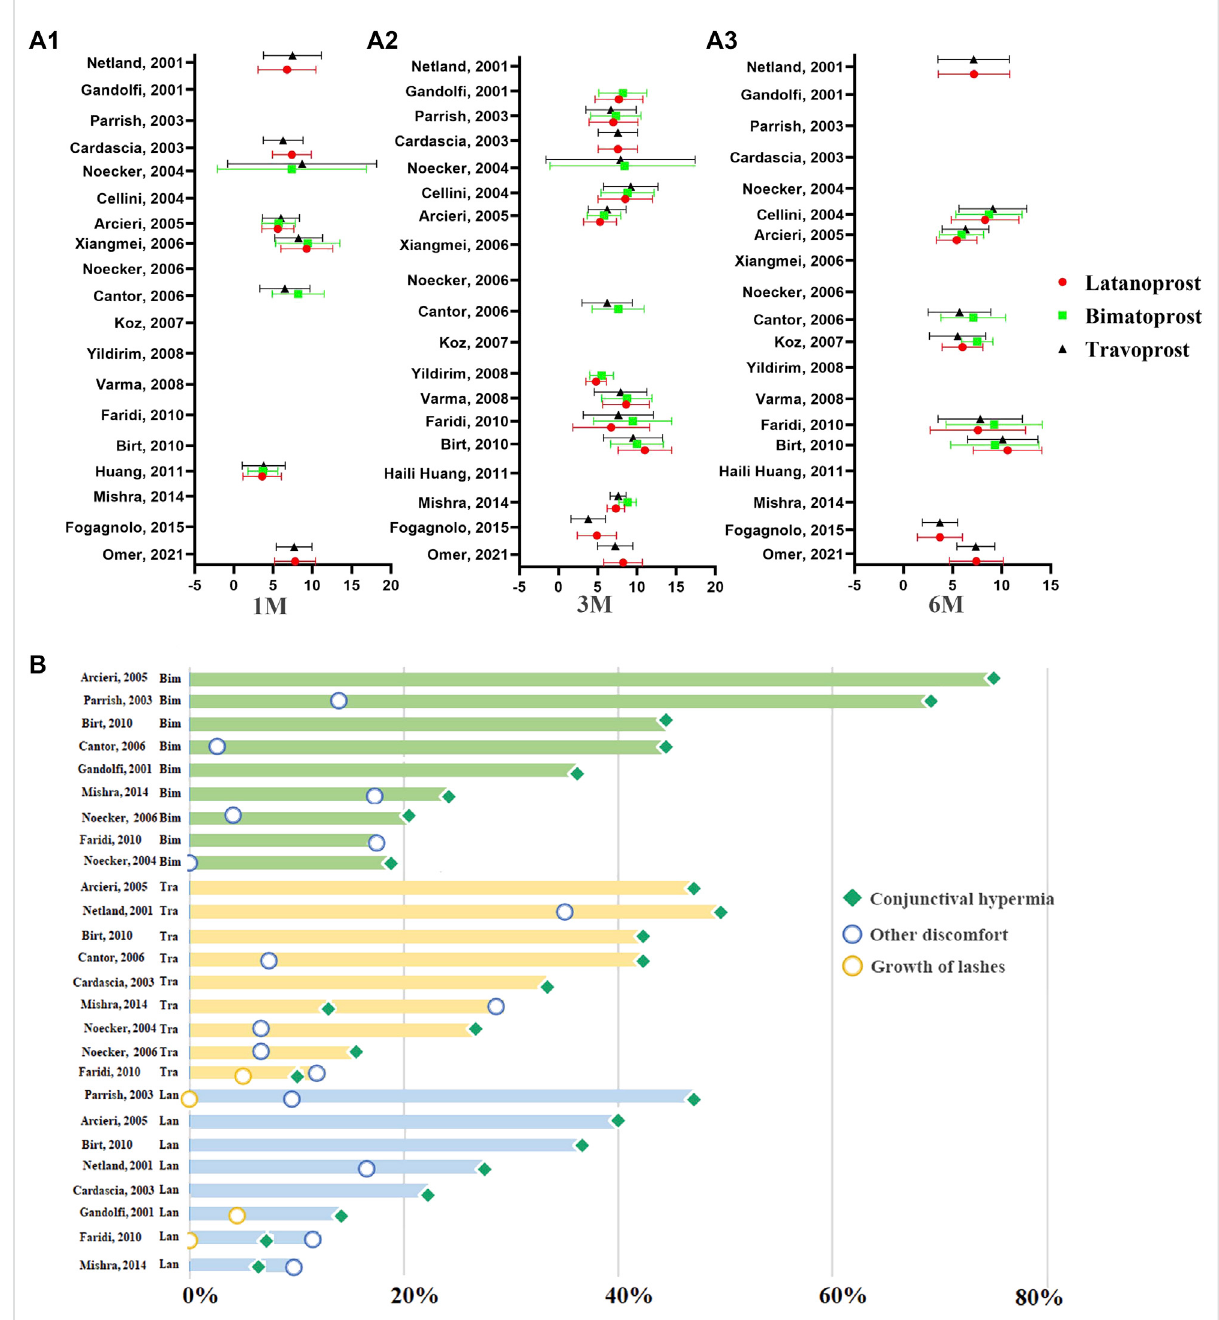
FIGURE 1 The distribution of IOP-lowering ef fi cacy of PGAs at different time points of therapy and the distribution of ocular side events of PGAs in previous RCTs. (A) The distribution of the IOP-lowering ef fi cacy of PGAs at 1M, 3M, and 6M. The abscissa represents the mean IOP reduction from baseline to theendpoint.The ordinate representsthedata fromdifferentreportedliteratures. (A1) :The distributionofIOP-loweringef fi cacyofPGAs at 1 month. (A2) : The distribution of IOP-lowering ef fi cacy of PGAs at 3 months. (A3) : The distribution of IOP-lowering ef fi cacy of PGAs at 6 months. Red circle: Latanoprost; Green square: Bimatoprost; Dark triangle: Travoprost. (B) The distribution of ocular side events of PGAs in previousRCTs.Thehorizontalaxisrepresentstheincidenceofocularsideeffects.Thepalegreencolumnsinthetoprepresenttheocularsideeffects inBimatoprost.ThefaintyellowcolumnsinthemiddlerepresenttheocularsideeffectsinTravoprost.Thepalebluecolumnsinthebottomrepresent the ocular side effects in Latanoprost. Green square: conjunctival hyperemia; yellow circle: growth of eyelashes; blue circle: other